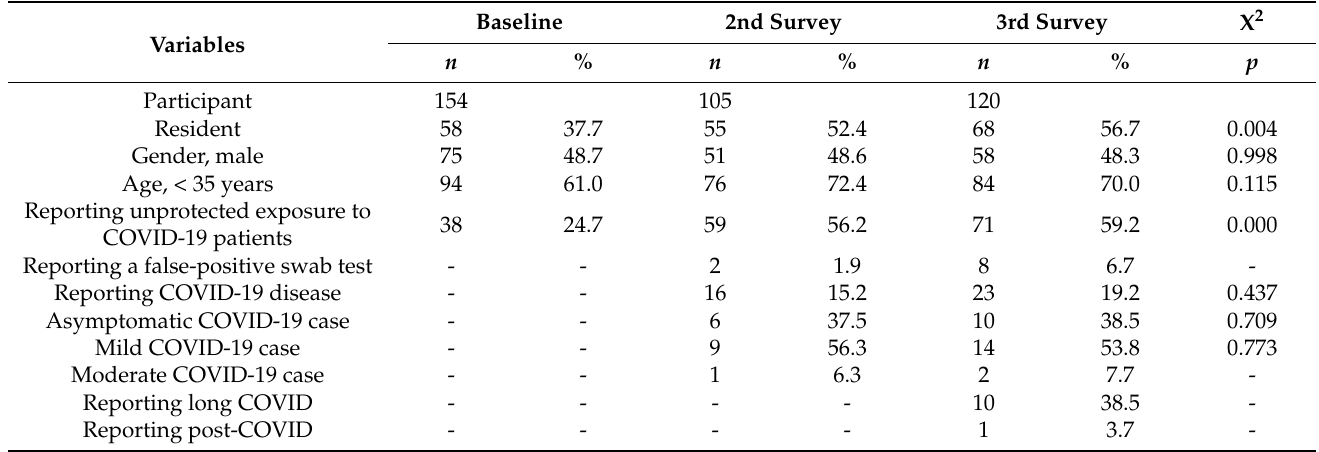
Table 1. Characteristics of the